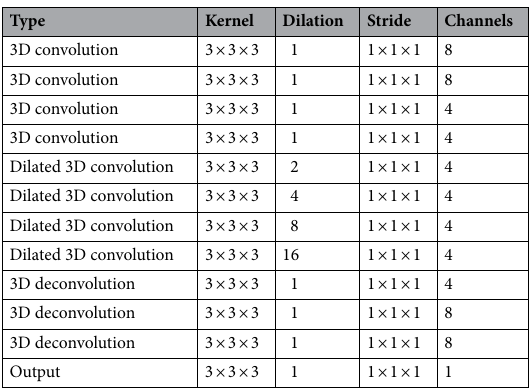
Table 1. Architecture summary of the 3D inpainting network. “Channels” refers to the number of kernels for the corresponding layer.